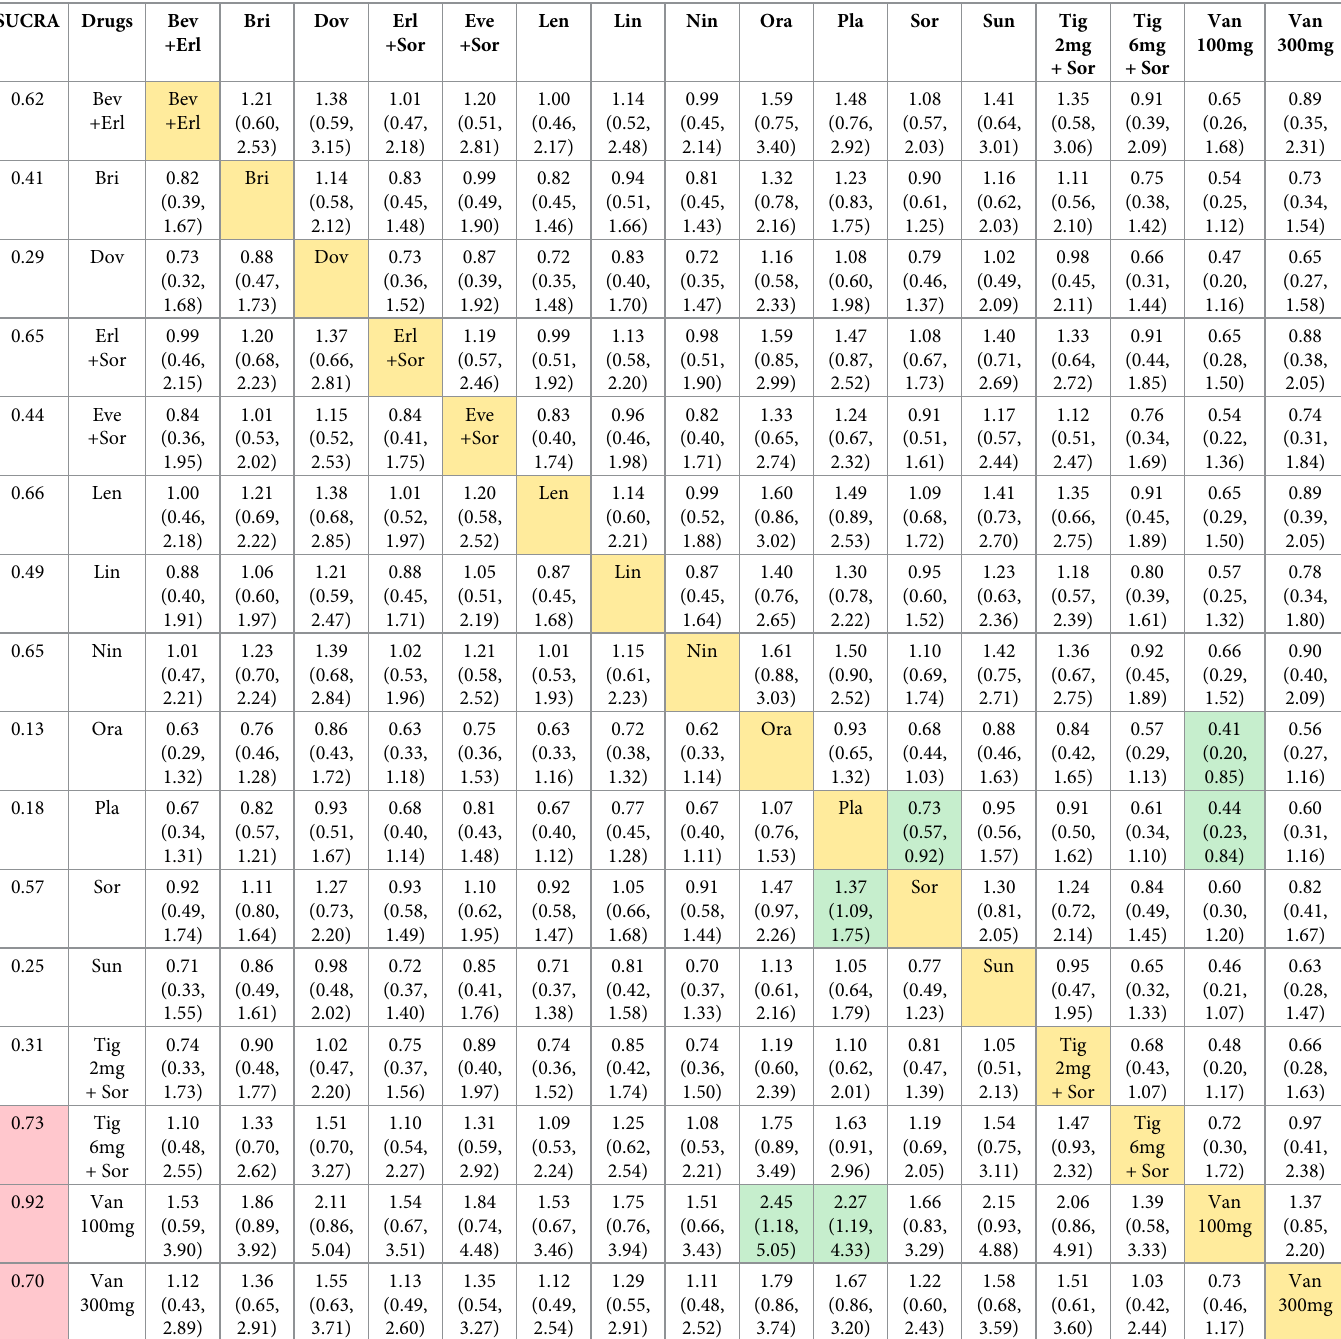
Table 4. Network meta-analyses for OS (Findings are expressed as HR (95% CrI), use of random-effect model). SUCRA Drugs Bev